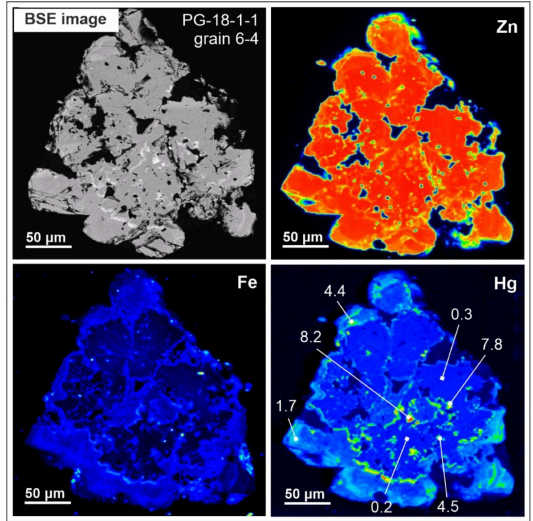
Figure 12. Back-scattered electron (BSE) images and element maps (Zn, Fe, Hg) showing irregular distribution of Hg in Pugachev MV sphalerite, with wt% Hg contents (EDS and WDS data) of selected points. For representative composition of sphalerite, see Table 4.